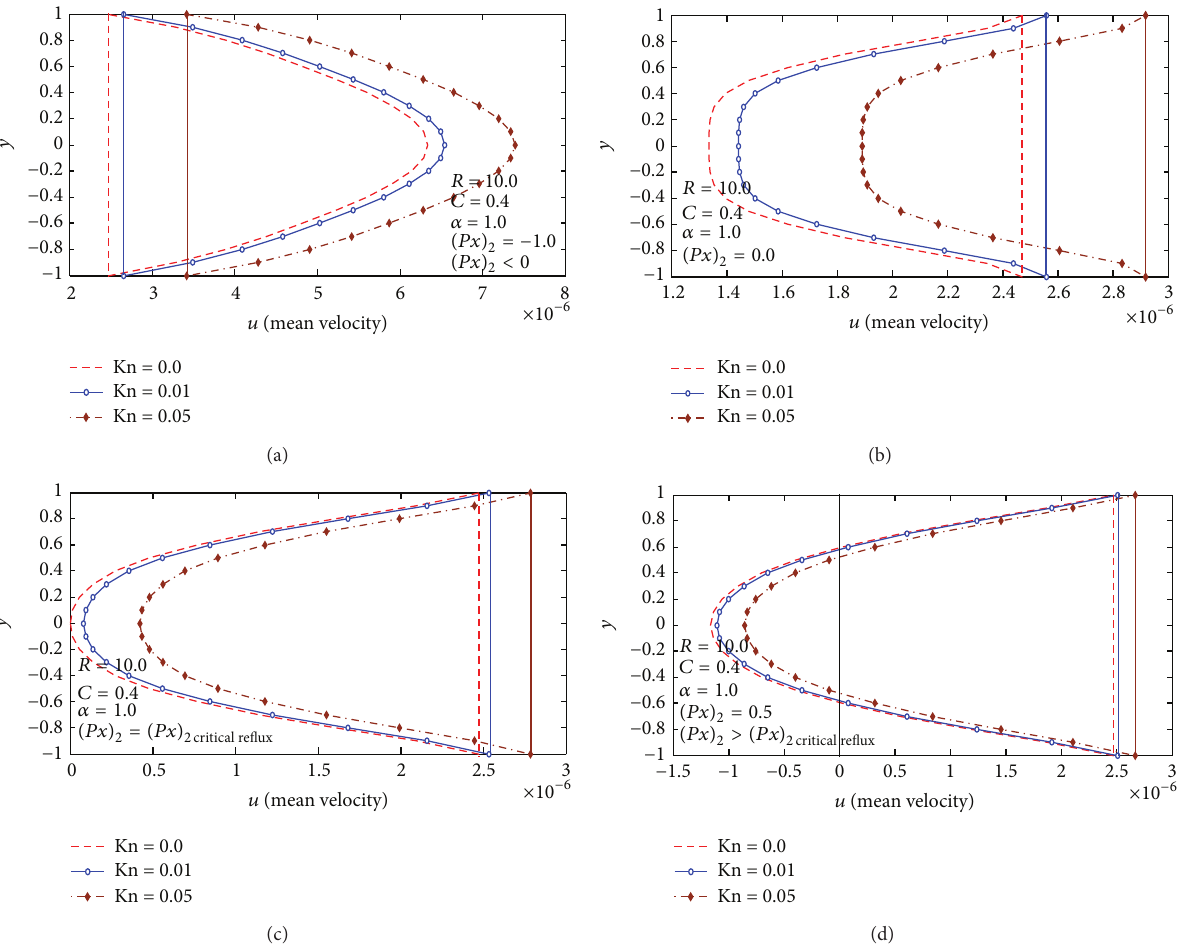
Figure 3: (a) Mean velocity distribution at (𝜕𝑝/𝜕𝑥) 2 = −1.0 . (b) Mean velocity distribution at (𝜕𝑝/𝜕𝑥) 2 = 0.0 . (c) Mean velocity distribution at (𝜕𝑝/𝜕𝑥) 2 = (𝜕𝑝/𝜕𝑥) 2 Critical reflux . (d) Mean velocity distribution at (𝜕𝑝/𝜕𝑥) 2 = 0.5